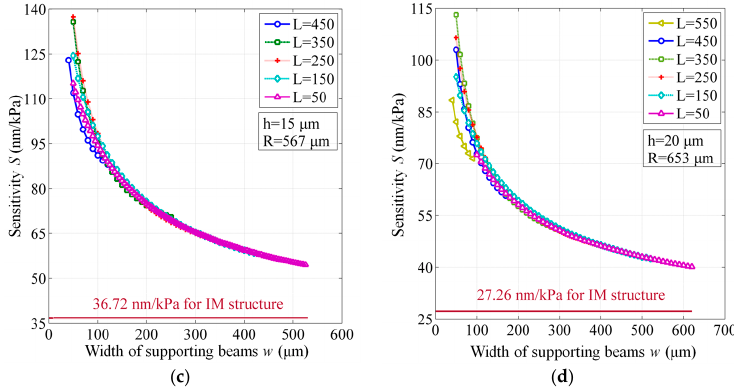
Figure 4. Sensitivity of BSM structures for different geometrical dimensions, compared to the constant values of IM structures. ( a ) Membrane thickness h = 5 μ m and radius R = 327 μ m; ( b ) h = 10 μ m and R = 462 μ m; ( c ) h = 15 μ m and R = 567 μ m; ( d ) h = 20 μ m and R = 653 μ m.